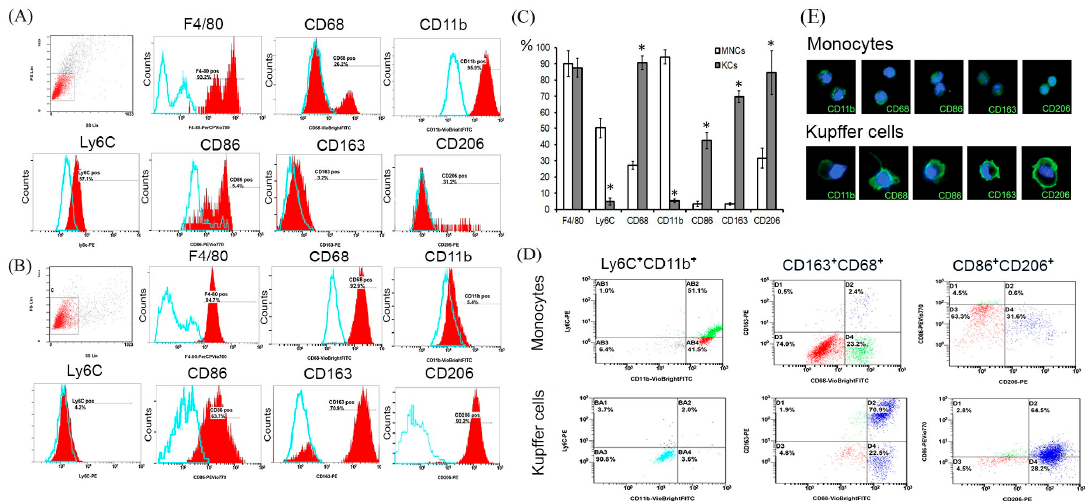
Figure 1. Immunophenotyping of Kupffer cells and monocytes by flow cytometry ( A – D ) and immunocytochemistry ( E ). Monocyte immunophenotypes ( A , C , D , E ), Kupffer cell immunophenotypes ( B – E ), the percentages of positive cells are indicated. The blue curve corresponds to the isotype control. Dot-plots of double positive cells are shown ( D ). Fluorescent microscopy images display immunostaining (FITC, green), cell nuclei are counterstained with 4 ′ ,6-diamidino-2-phenylindole (DAPI) (blue), ×400 ( E ). Comparative analysis of markers expression in monocytes and Kupffer cells according to the flow cytometry assessment ( C ). The data are listed as mean ± standard deviation. * p < 0.05 monocytes vs Kupffer cells. KCs: Kupffer cells; MNCs: monocytes. Table 1. Antibodies used in the flow cytometry assay. Antibody Isotypic Control